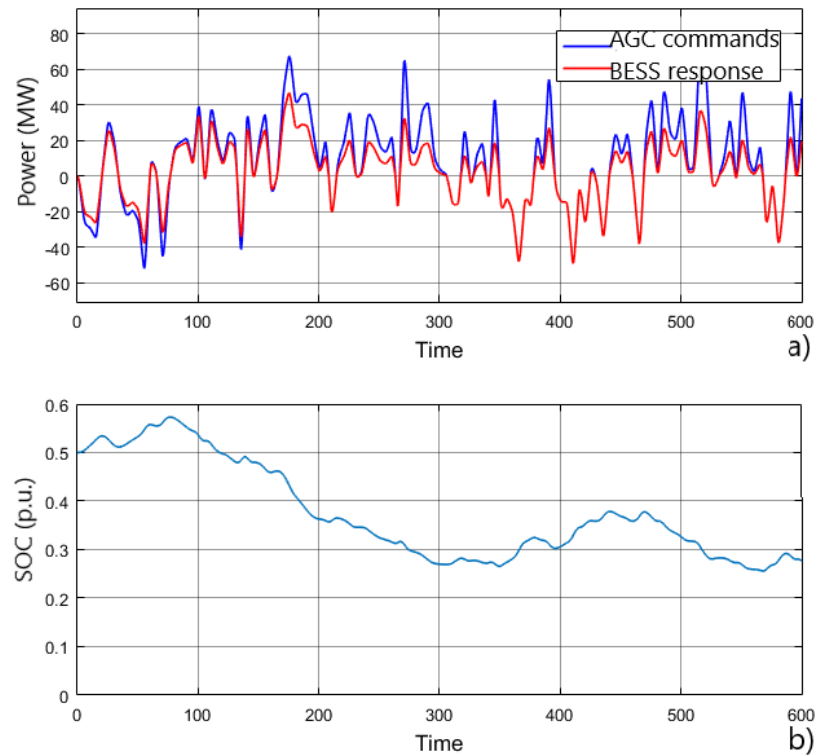
Figure 5. One hundred MW, 1 h BESS power ( a ) and SoC ( b ) response for 18 GW of wind power